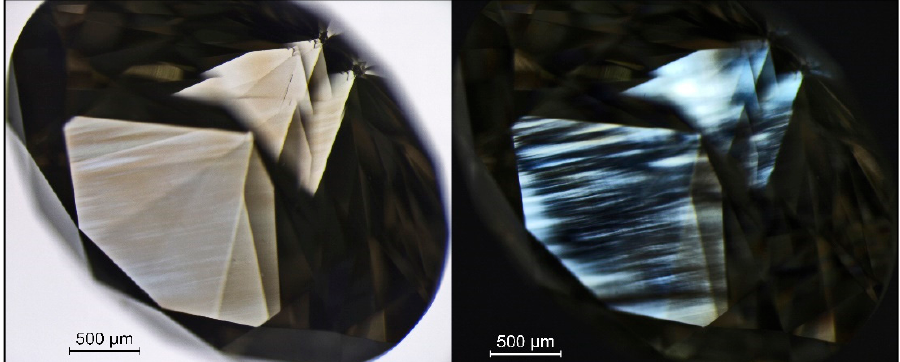
Figure 24. A brown type IIa diamond (sample TH 2.612) in immersion (left) showing the characteristic plastic deformation-related brown “graining” along (111), and the corresponding extinction patterns as shown under crossed polarizing filters (right).